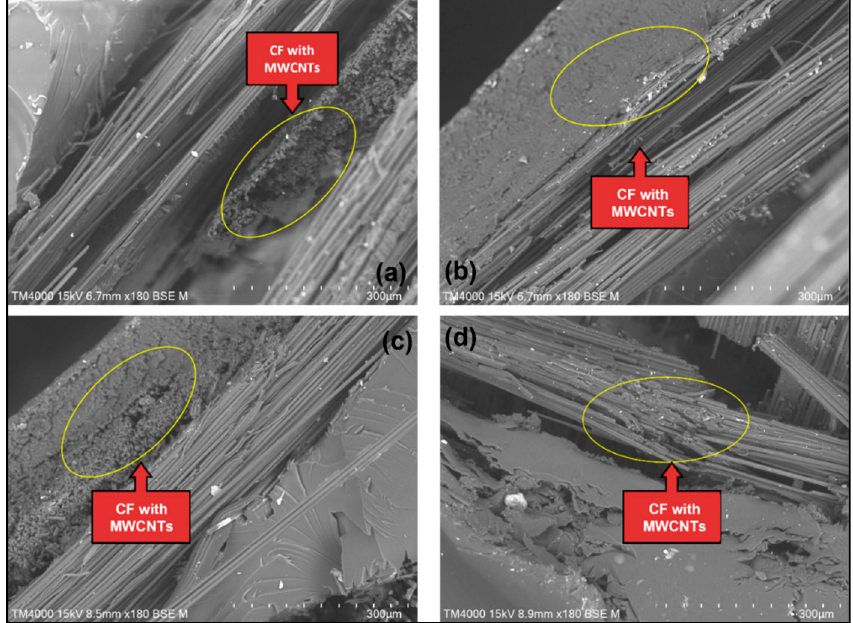
Figure 5. SEM images of CNT–CF/epoxy composites when deposition voltage is 20 V and deposition time is 15 min: ( a ) 0% water, ( b ) 20% water, ( c ) 80% water, ( d ) 100% water.